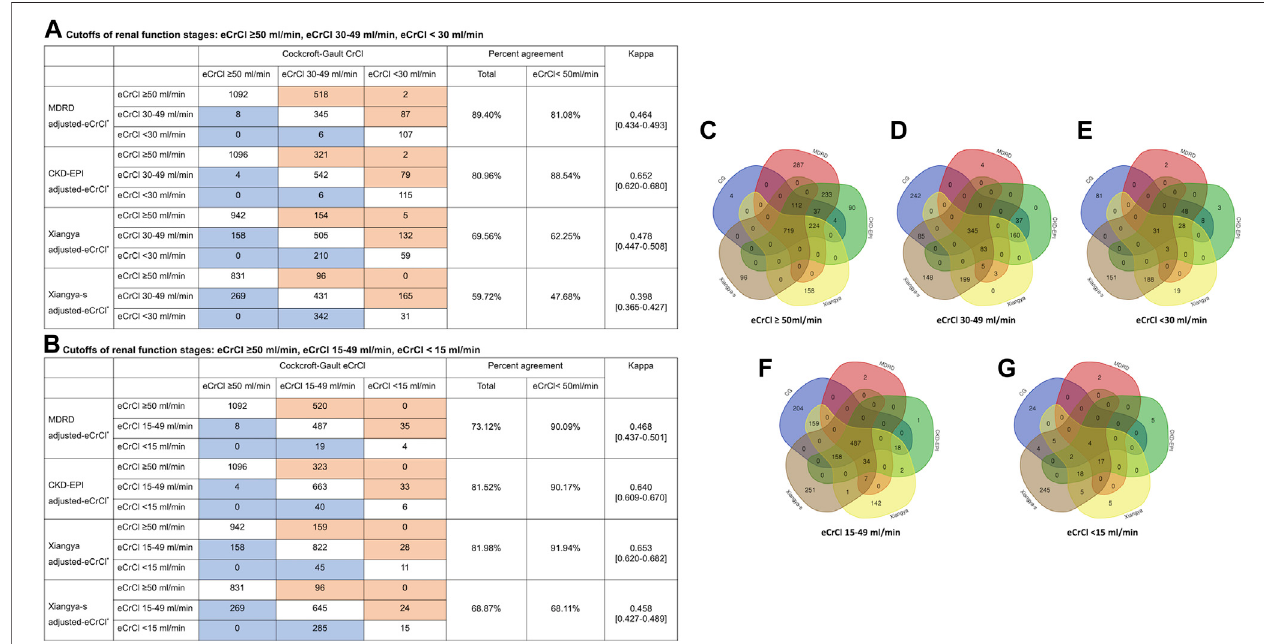
FIGURE 3 | Impact of equations choices on patients ’ renal stages (A, B) in confusion matrices and patient selection for eCrCl-based DOACs dosing adjustment (C – G) . The eCrCl cutoffs were as follows: (A) eCrCl ≥ 50 ml/min, eCrCl 30 – 49 ml/min, eCrCl < 30 ml/min; (B) eCrCl ≥ 50 ml/min, eCrCl 15 – 49 ml/min, eCrCl < 15 ml/ min; (C) eCrCl ≥ 50 ml/min; (D) eCrCl 30 – 49 ml/min; (E) eCrCl < 30 ml/min; (F) eCrCl 15 – 49 ml/min; (G) eCrCl < 15 ml/min. DOACs, direct oral anticoagulants; eCrCl, estimatedcreatinineclearance;CG,Cockcroft-Gault;MDRD,Modi fi